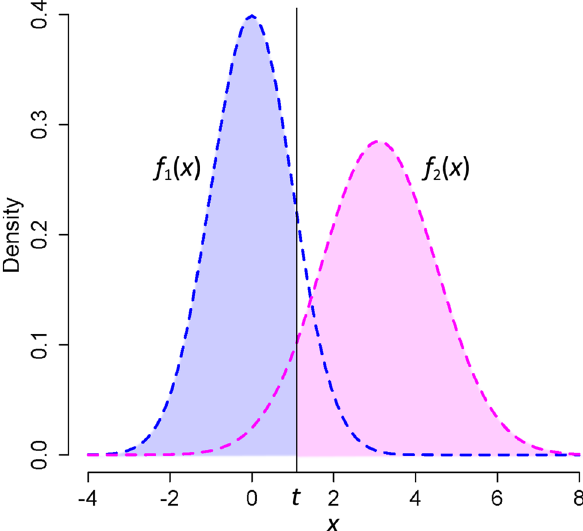
Figure 6. An example of the probability density functions of a continuous variable x used to classify the input value to binary outcome (say a diagnostic test) for the negative class ( f 1 ( x ), blue dashed line) and positive class ( f 2 ( x ), magenta dashed line). The negative and positive classes may correspond to non-diseased and diseased people, respectively. The cut-off value of t is represented by the vertical solid line. The area under f 2 ( x ) to the right of the cut-off value (the pink region) is then the sensitivity ( Se ), and the area under f 1 ( x ) to the left of the cut-off value (the light blue region) is the specificity ( Sp